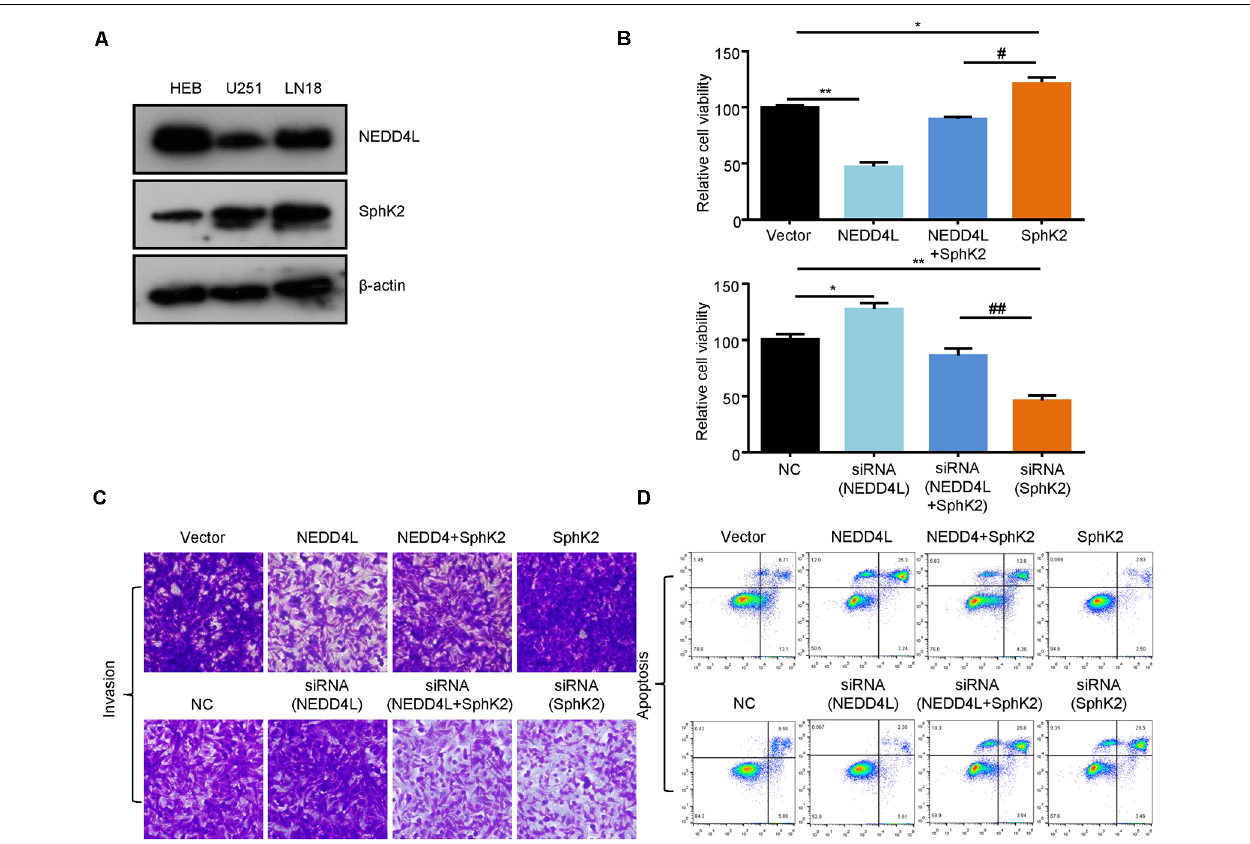
FIGURE 4 | Ubiquitination of SphK2 suppresses glioma cell progression in vitro . (A) The expression levels of SphK2 and NEDD4L in normal brain cells and glioma cells. (B–D) Glioma U251 cells were transfected with NEDD4L and/or SphK2 overexpression plasmid or transfected with NEDD4L and/or SphK2 siRNA, and cell viability, apoptosis, and invasion were measured by the CCK8 assay, invasion assay, and flow cytometry assay in sequence. * P < 0.05, ** P < 0.01 compared with the vector or NC; # P < 0.05, ## P < 0.01 compared with SphK2 overexpression plasmid or